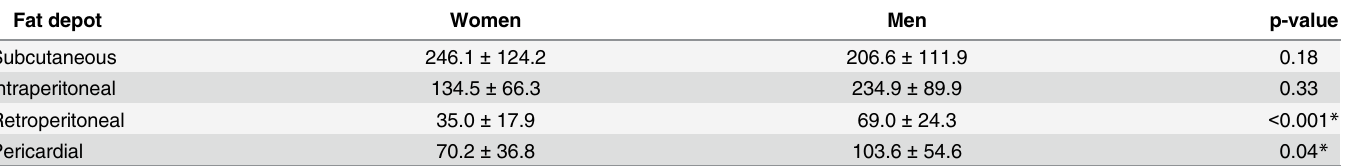
Table 2. Fat depot volumes in men and women.